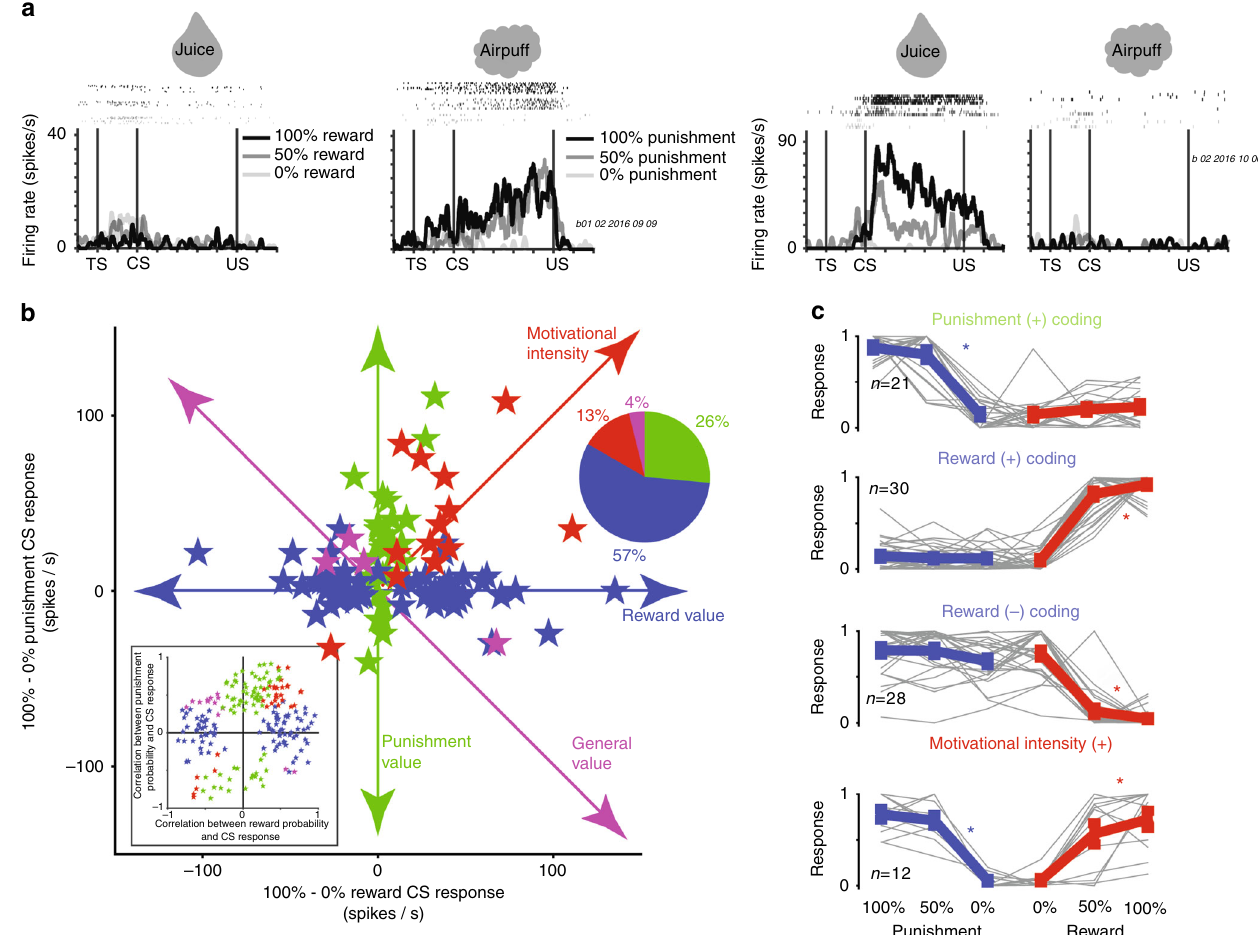
Fig. 2 Many ACC neurons signal outcome probability in a valence-speci fi c manner. a Two single ACC neurons, one that signals punishment probability ( left ) and one that signals reward probability ( right ). b Scatter plot shows the difference in CS responses for 100 and 0% CSs in the reward block ( x -axis) vs. difference in CS responses for 100 and 0% CSs in the punishment-block ( y -axis). Green — neurons displayed signi fi cant differences between 100 and 0% CSs in the punishment block only, blue — neurons that displayed signi fi cant differences between 100 and 0% CSs in the reward block only, red — neurons that displayed signi fi cant differences between 100 and 0% CSs in both blocks and both differences were either positive or negative, and purple — neurons that displayed signi fi cant differences between 100 and 0% CSs in both blocks and the differences were of different sign. Colors in pie chart ( inset ) correspond to colors in scatter plot and in Fig. 1c. Uncertainty-selective neurons are studied separately in Fig. 3. ( b , inset ) Correlation coef fi cients of all recorded neurons that displayed signi fi cant correlations with either reward or punishment probabilities, or both. Signi fi cance of each correlation was tested by 10,000 permutations ( p < 0.05). c Single neuron responses ( gray ) shown separately for four major groups of outcome probability coding neurons in the scatter plot in b . Single neurons ’ CS responses were normalized to the maximum CS response; from 0 to 1. Red asterisks indicate that the neurons ’ responses varied signi fi cantly across the CSs within the reward block (Kruskal – Wallis test; p < 0.01) and displayed signi fi cant correlation with outcome probability (Spearman ’ s rank correlation; p < 0.01); blue asterisks indicate that the neurons ’ responses varied signi fi cantly across the CSs within the punishment block (Kruskal – Wallis test; p < 0.01) and displayed signi fi cant correlation with outcome probability (Spearman ’ s rank correlation; p <